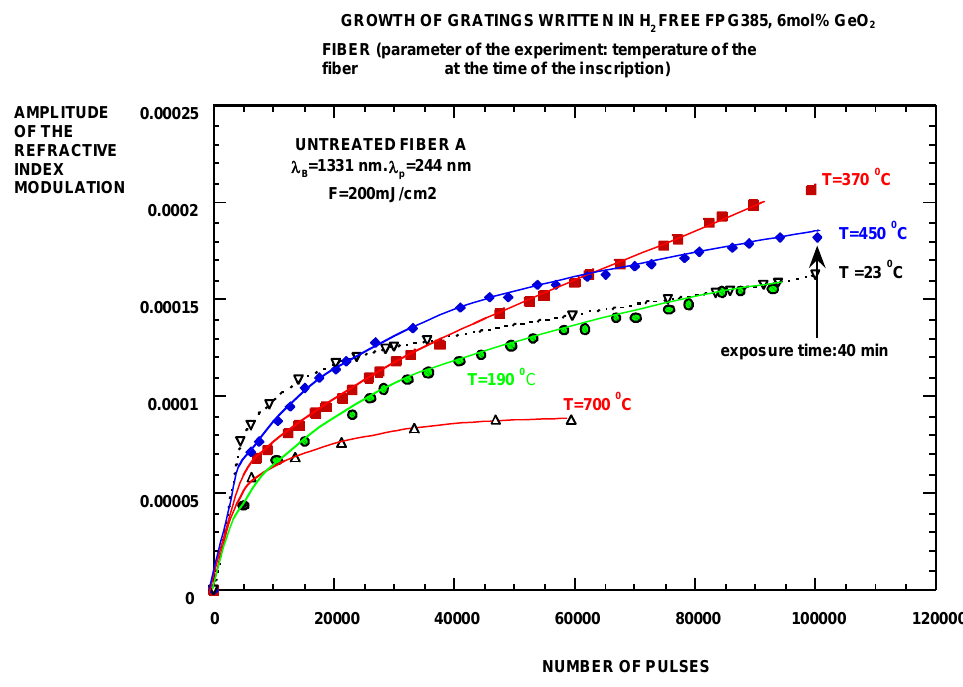
Figure 37. Writing kinetics results from Bernage et al. , reprinted with permission from [4]. Copyright 1996 University Lille